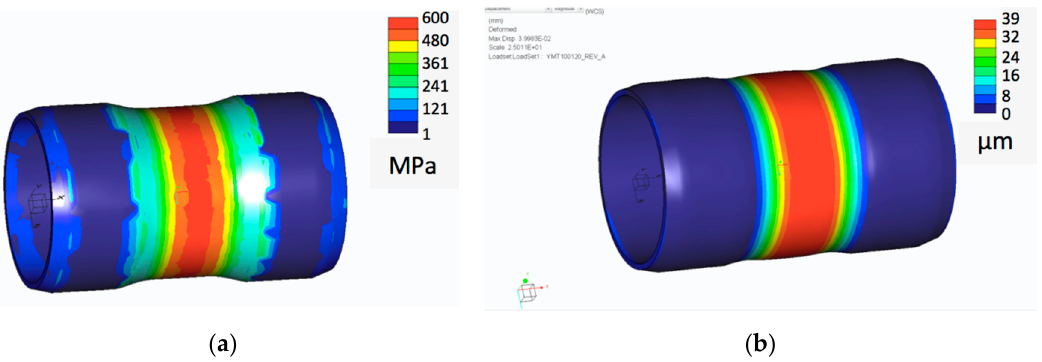
Figure 6. Examples of FEM simulation: ( a ) stress distribution; ( b ) deformations.